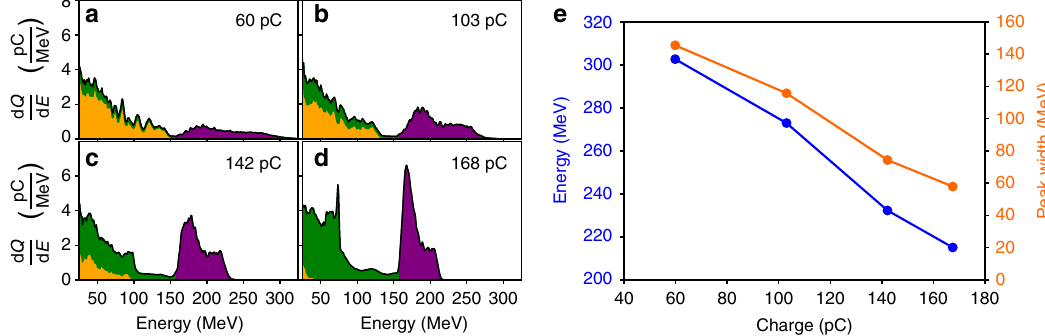
Fig. 5 PIC simulation results illustrating beam loading effects. a – d Electron energy histograms for increasing injected charges within the energy peak ( purple area ). The green- and purple-shaded area is the contribution from electrons originating from nitrogen, and orange-shaded area from helium electrons. The black line indicates the cumulative spectrum. a Corresponds to the histogram seen in Fig. 4a. e Shown is how maximum attained energy E max ( left axis ) and beam energy spread ( right axis ) depend on injected